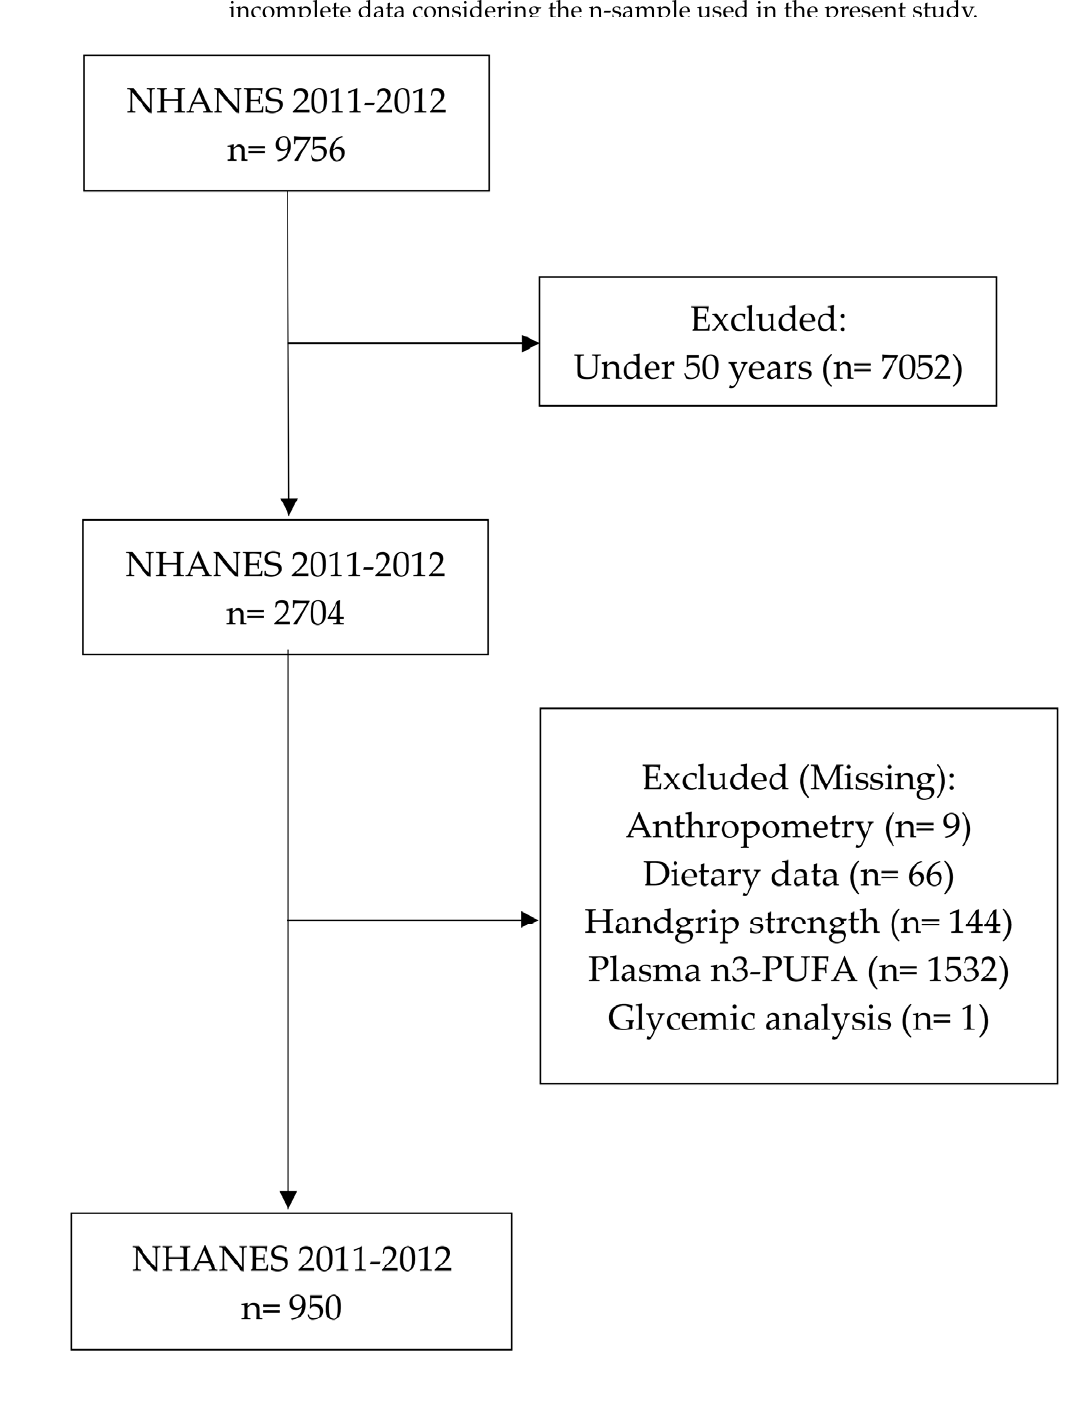
Figure 1. Flowchart of the sample selection from NHANES 2011–2012.